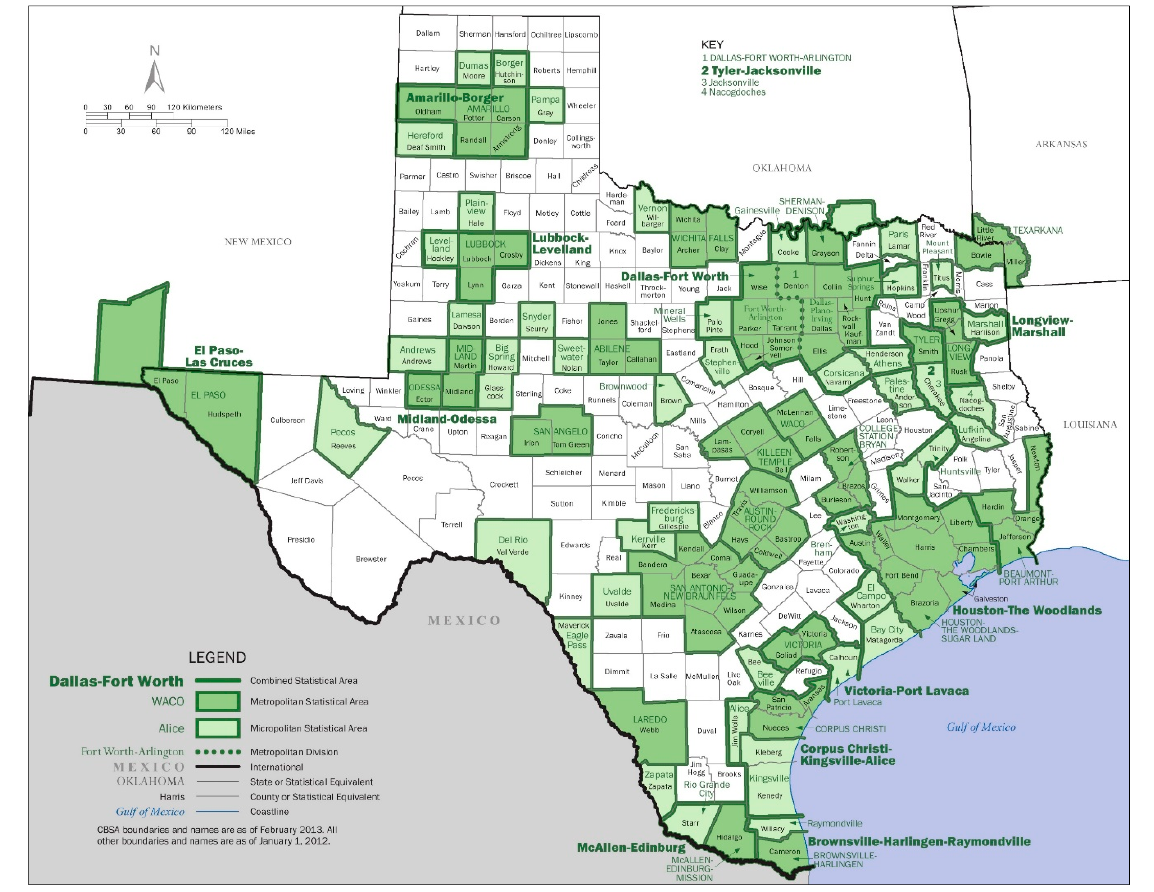
Figure 6. Metropolitan-/Micropolitan Areas and Counties in Texas (Credit: U.S. Census Bureau [45]).